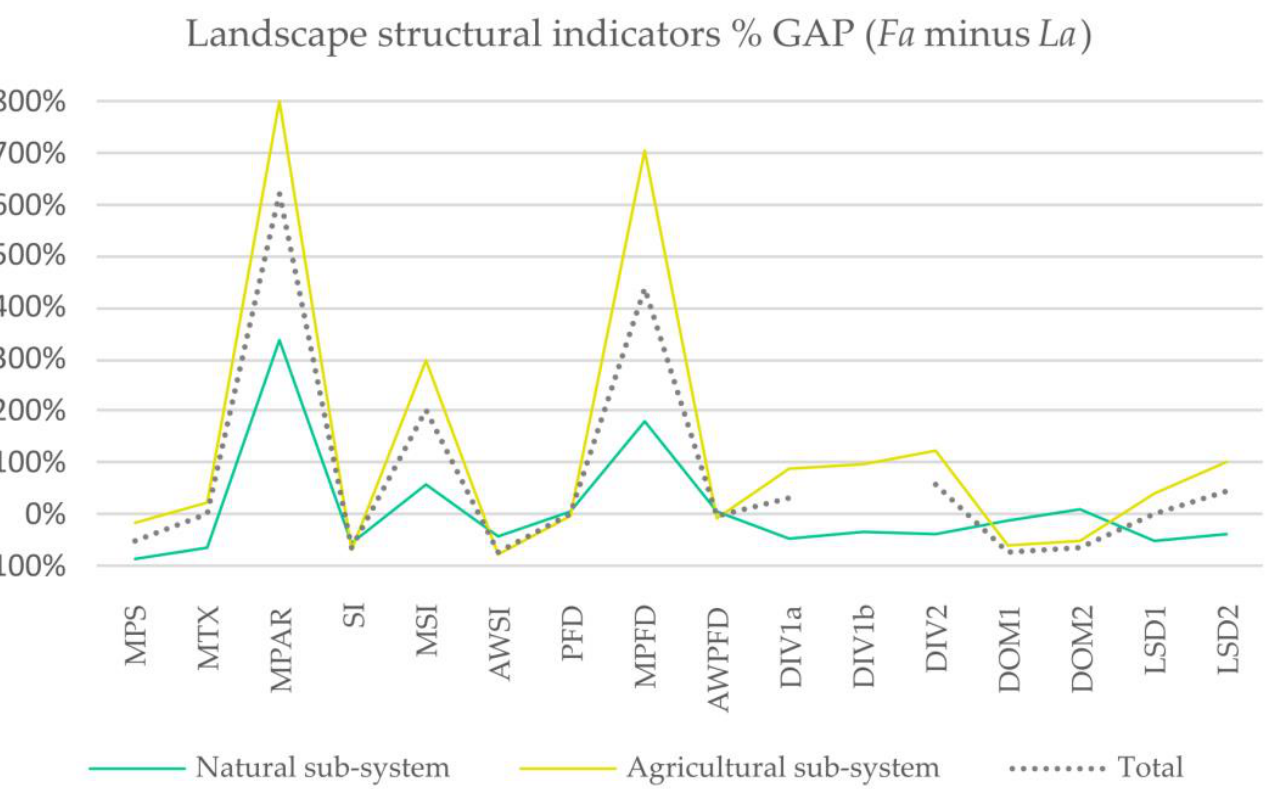
Figure 4. Percentage gaps between farm ( Fa ) and local ( La ) scale landscape structural indicator values, calculated separately for the natural and agricultural sub-systems, and then jointly for the total landscape system [Shape Indices (MPS: Medium patches size; MTX: Matrix; MPAR: Mean Perimeter area ratio; SI: Shape index; MSI: Mean Shape index; AWSI: Area weighted mean shape index; PFD: Patch fractal dimension; MPFD: Mean patch fractal dimension; and AWPFD: Area weighted mean patch fractal dimension) and Composition Indices (DIV1a: Diversity_1a/tot; DIV1b: Diversity_1b /landscape element; DIV2: Diversity_2; DOM1: Dominance_1; DOM2: Dominance_2; LSD1: Landscape Structural Diversity_1; and LSD2: Landscape Structural Diversity_2)]. Table 3. Correlation coefficients matrixes for shape indices (MPAR: Mean Perimeter area ratio; SI: Shape index; MSI: Mean Shape index; AWSI: Area weighted mean shape index; PFD: Patch fractal dimension; MPFD: Mean patch fractal dimension; and AWPFD: Area weighted mean patch fractal dimension) and for composition indices (DIV1a: Diversity_1a /tot; DIV1b: Diversity_1b /landscape element; DIV2: Diversity_2; DOM1: Dominance_1; DOM2: Dominance_2; LSD1: Landscape Struc- tural Diversity_1; and LSD2: Landscape Structural Diversity_2). SHAPE INDICES